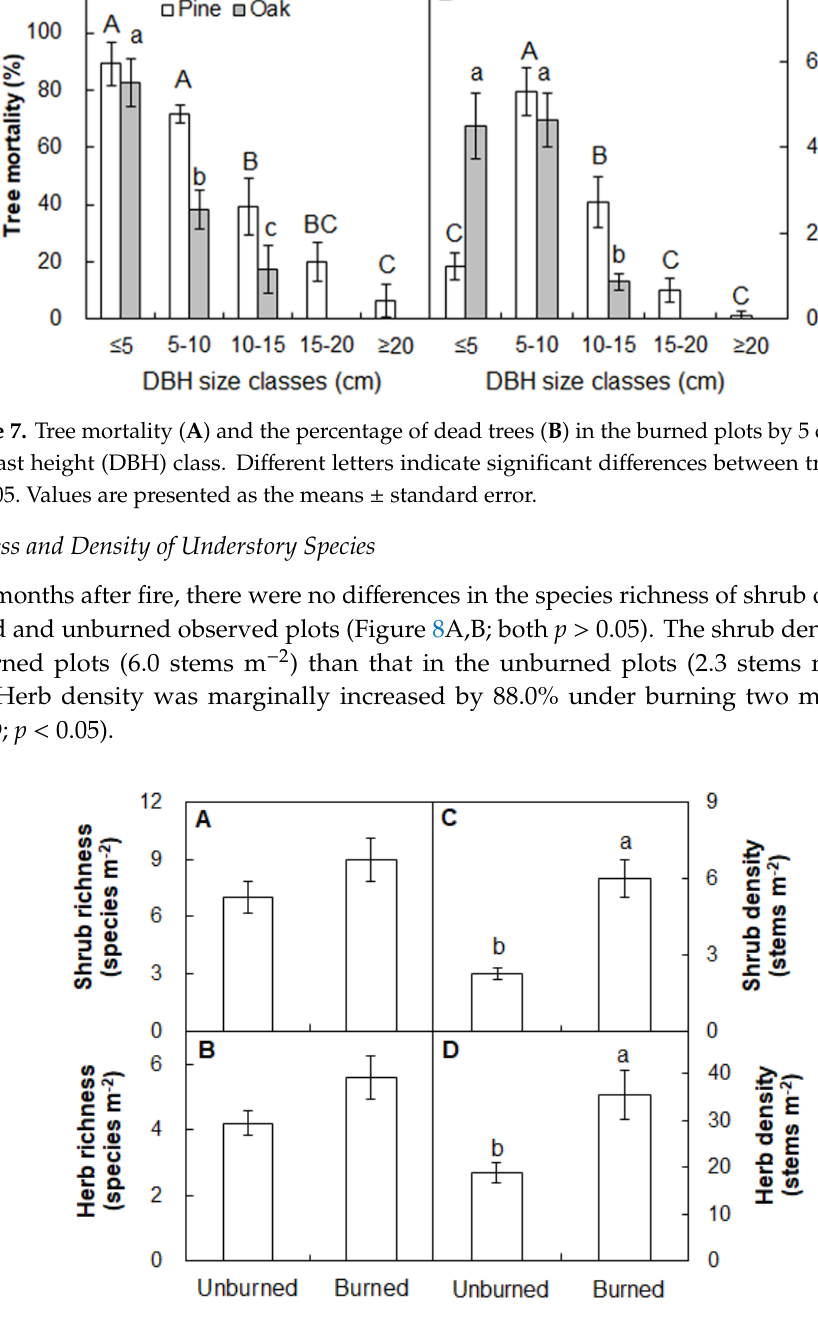
Figure 6. Differences in tree density between the unburned and burned plots. Different letters indicate significant differences between treatments at p < 0.05. Values are presented as the means ± standard error.